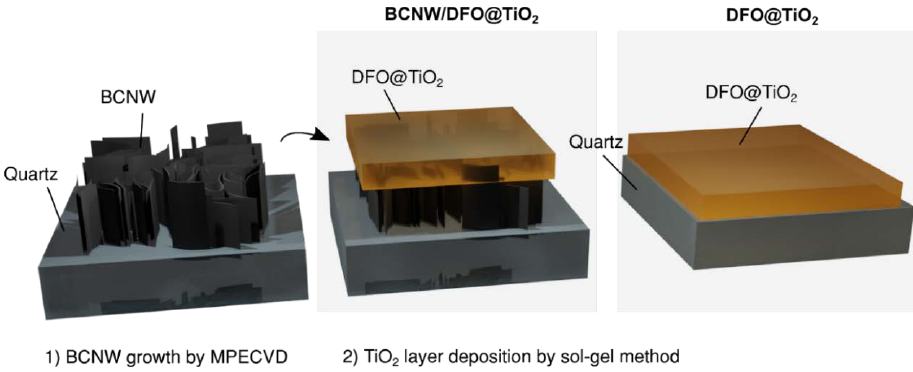
Figure 1. The scheme of obtaining DFO/TiO 2 and DFO/TiO 2 /CNW thin films.